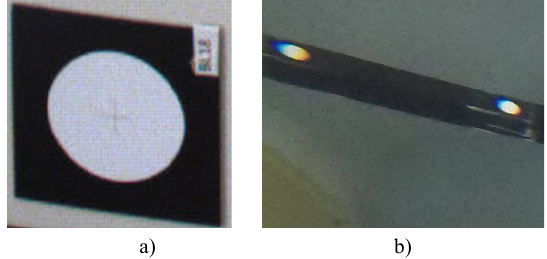
Figure 1. Chromatic aberration in a) a Ladybug5 image and b) an underwater GoPro Hero 5